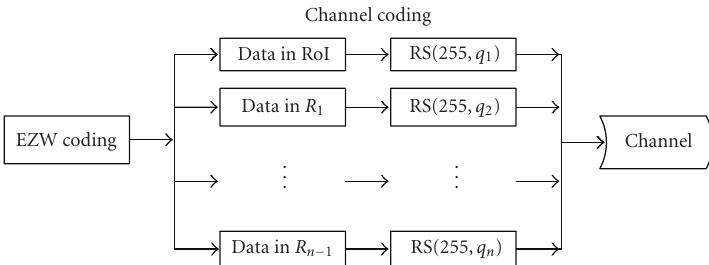
Figure 3: The transmitter including the proposed channel coding block diagram.